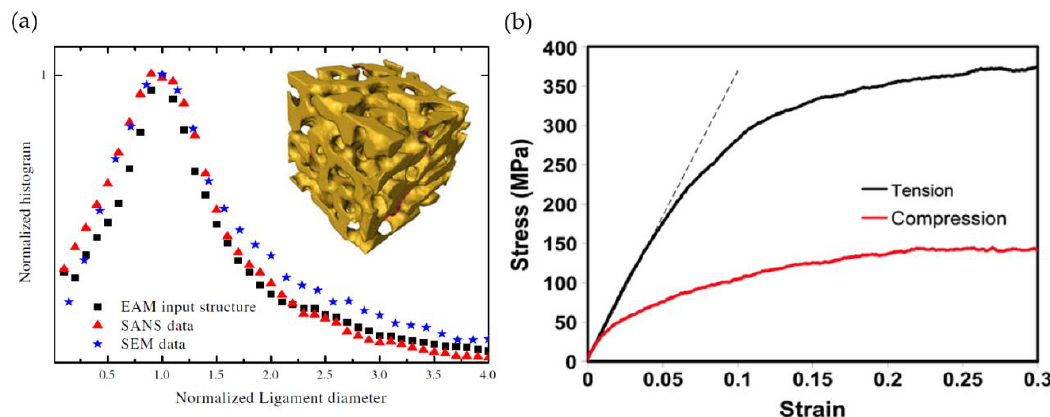
Figure 12. ( a ) Model of np-Au by Crowson et al. [111] and ( b ) the predicted stress–strain curve for tension and compression, showing significant asymmetry due to surface effects by Farkas et al. [112]. Reprinted from [111] and [112] with permission from Elsevier.